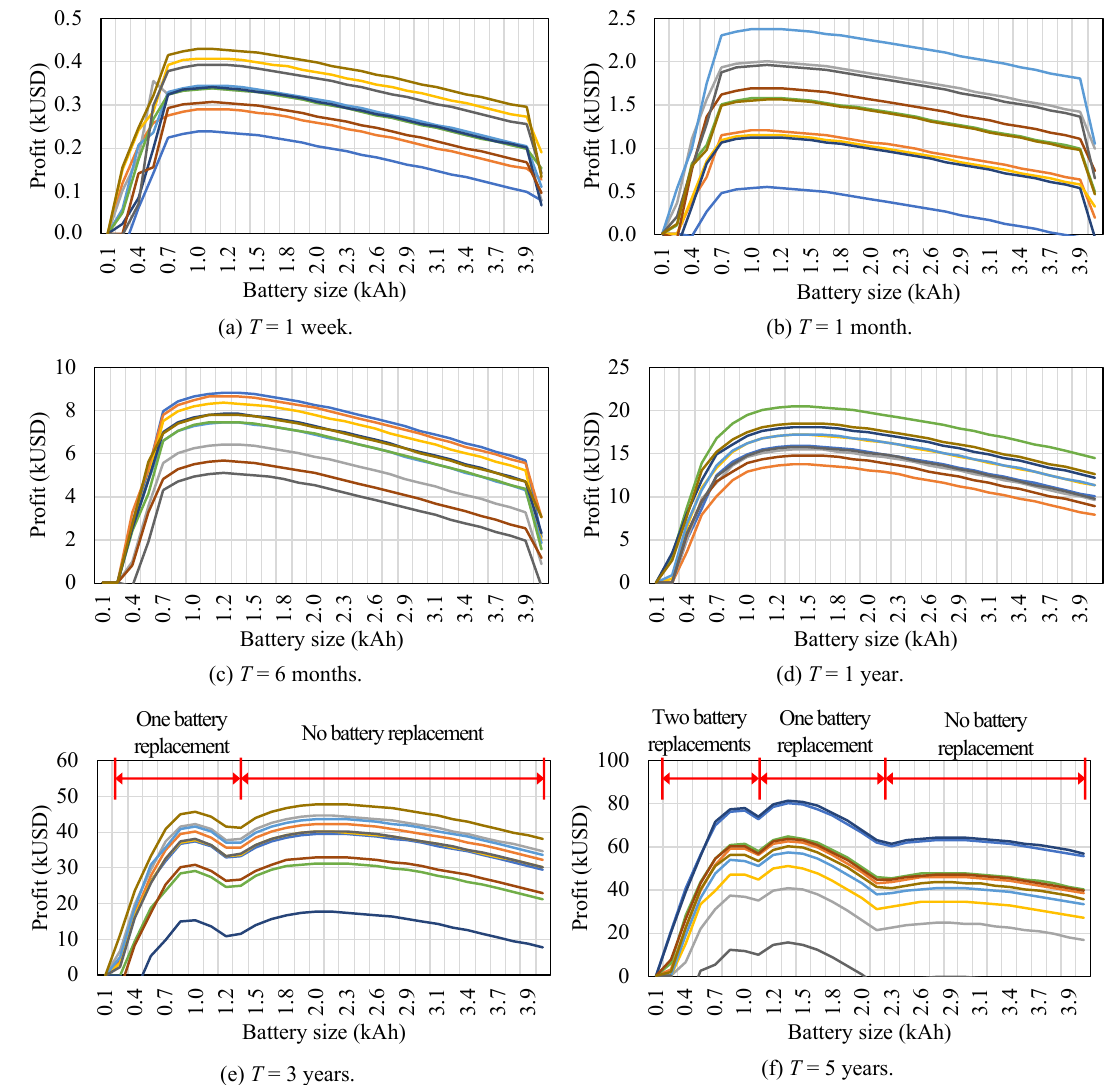
Figure 8. Profit comparison when ( a ) T < 1 week, ( b ) T < 1 month, ( c ) T < 6 months, ( d ) T < 1 year, ( e ) T < 3 years, and ( f ) T < 5 years,